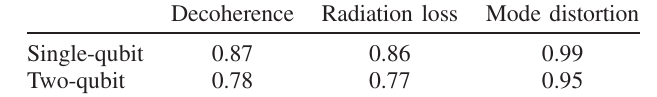
TABLE I. Relative contribution of decoherence, radiation loss, and mode distortion to the total process fidelity resulting from simulations described in the text. The contribution of decoherence to the two-qubit process fidelity is estimated from the measured process fidelity and the simulated values of the other two contributions. The total fidelity is given by the product of the relative